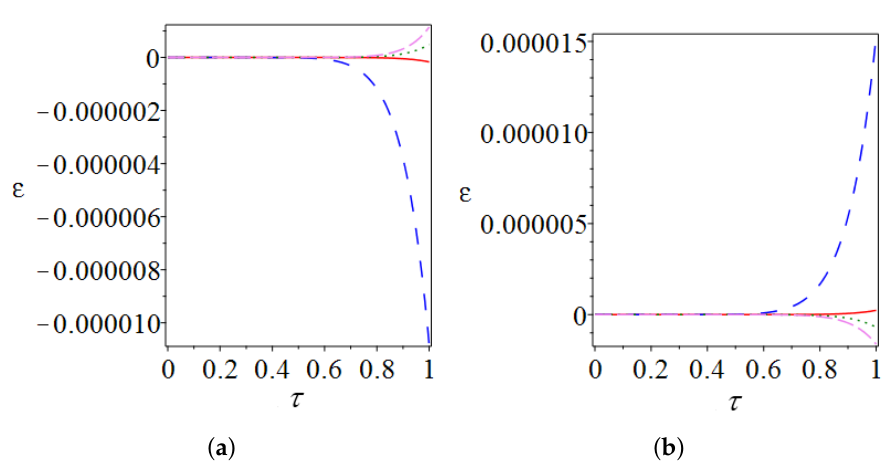
) / ϕ Figure 7. Error ε = ( ϕ i − ϕ analytic 20 of Greenspan II method for ( a ) ϕ 1 and ( b ) ϕ 2 angles for i a single time step. τ = 1 means ≈ 5 largest periods and ≈ 12 smallest periods.